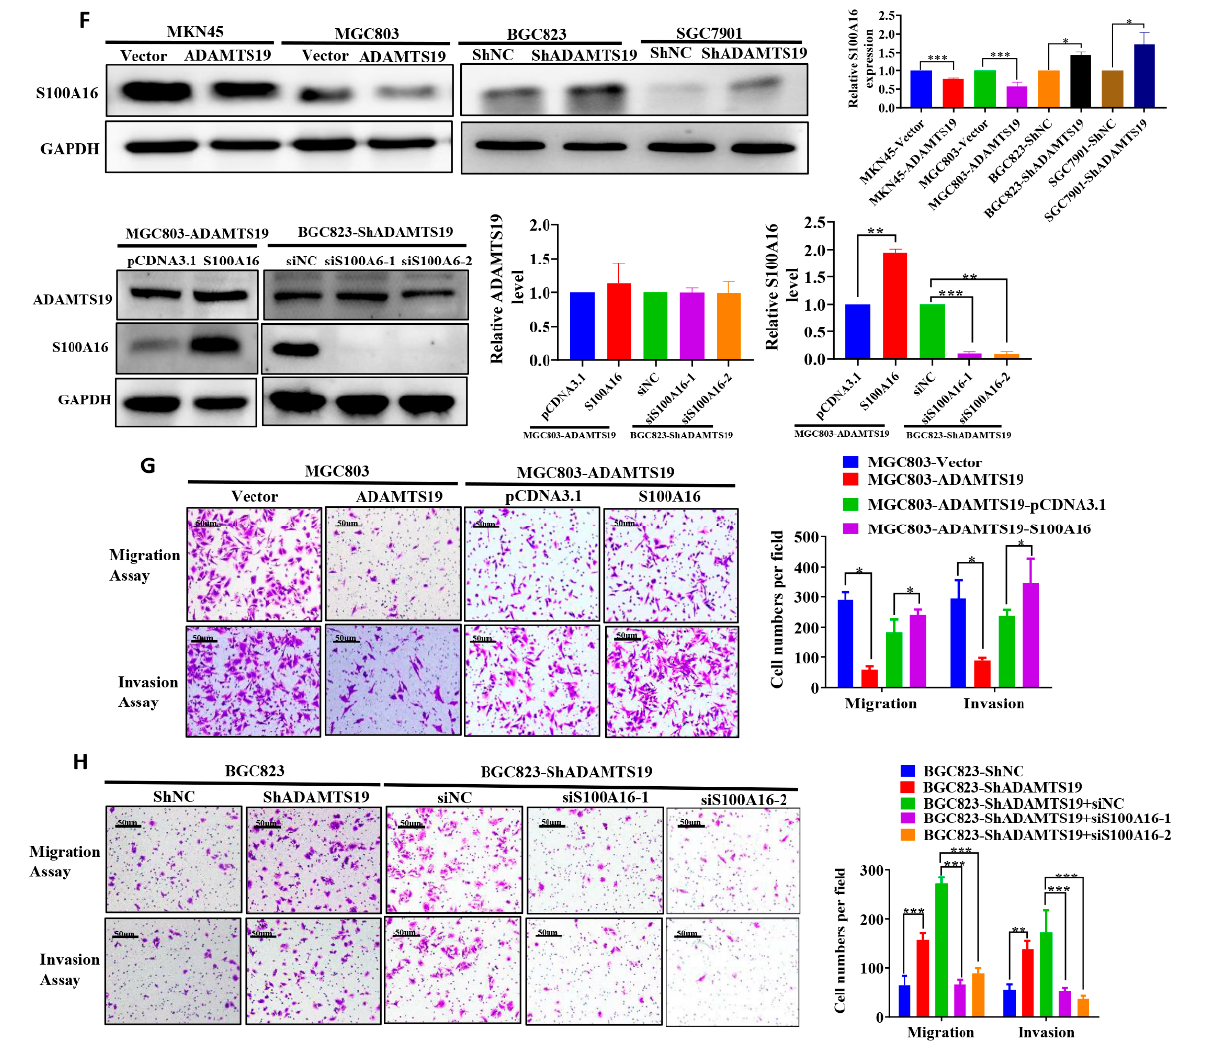
Figure 3. S100A16 is a downstream of ADAMTS19 and acts as a tumor promoter, promoting cell migration and invasion. ( A ) Heat map analysis showed altered genes in MGC803-ADAMTS19 and MGC803-vector cells. ( B ) Gene Ontology analysis showed that the altered genes are involved in biological processes, such as cell adhesion, extracellular matrix organization, inflammatory response, and cell surface receptor signaling pathway. ( C ) Gene set enrichment analysis (GSEA) showed the enrichment of ADAMTS19-associated genes in HALLMARK_TNF_SIGNALING VIA_NFKB and other pathways. The plot was drawn using R and RStudio. ( D ) Dual-luciferase gene reporter assays revealed that ADAMTS19 could regulate the S100A16 transcription directly in MKN45 and BGC823. ( E , F ) Quantitative RT-PCR and Western blot analysis showed that S100A16 protein levels were affected by ADAMTS19. ( G , H ) Ectopic expression of S100A16 reversed the inhibition of cell migration and invasion by ADAMTS19 in MGC803 and BGC823 cells. The data are presented as means ± standard deviations. * p < 0.05; ** p < 0.01; *** p < 0.001.